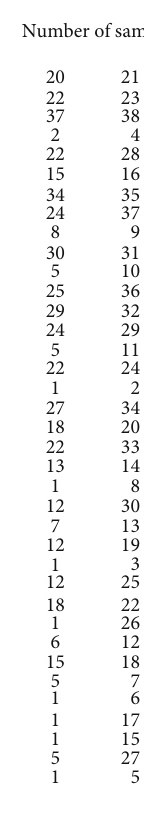
Figure 6: Clustering hierarchical diagram by correlation coe ffi cient group averaging